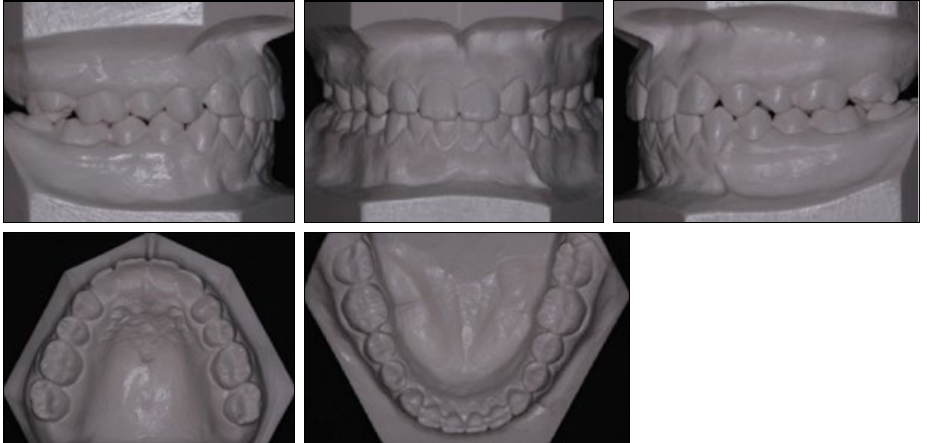
Figure 14. Photographs of dental casts after debonding of all